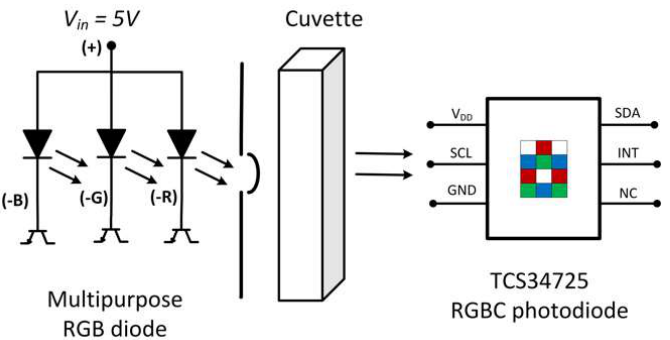
Figure 3. Diagram of common anode photon-emission controlled by transistor matrix and cuvette, and representation of RGBC TCS34725 photodiode.